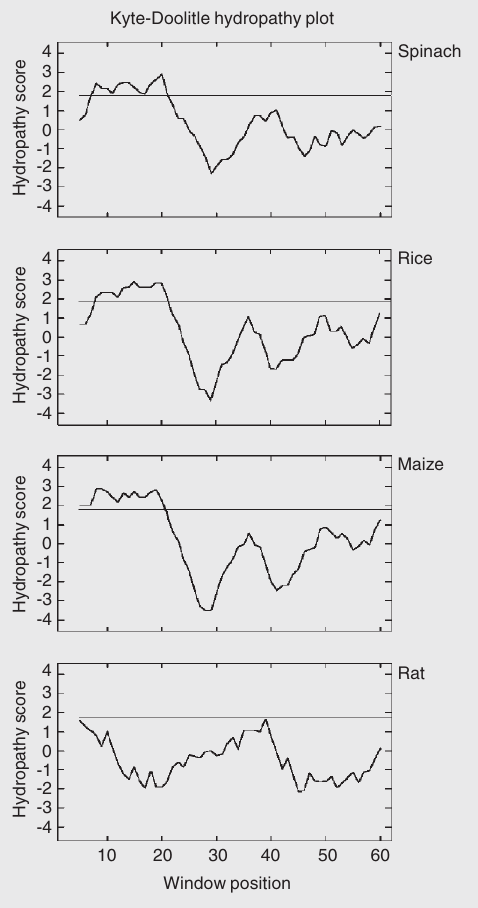
Figure 4. Kyte-Doolittle hy- dropathy plot of the first 60 N- terminal amino acids of mem- brane-bound hexokinases found in spinach, rice, maize, and rat brain. The thick hori- zontal line shows the hy- dropathy score limit at which the sequence presented a highly hydrophobic character. In plants the first 20 amino acids are mostly above the